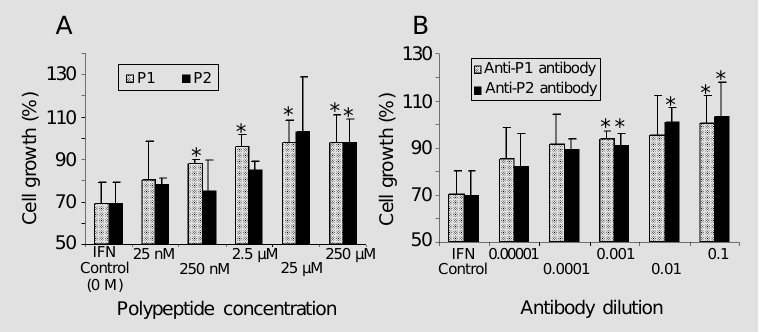
a B by polypeptide (A) or by polyclonal a B.